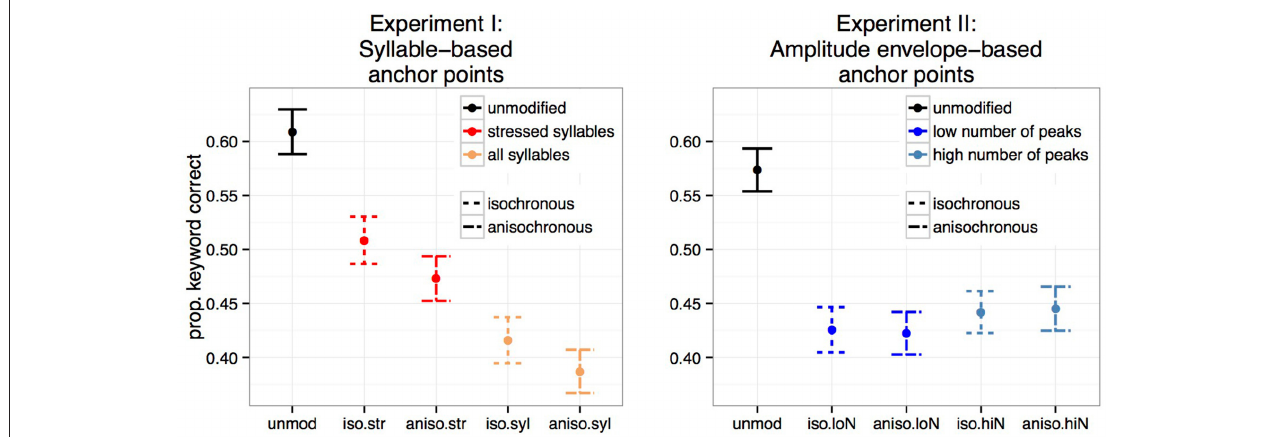
FIGURE 4 | Mean proportion of correctly identified keyword per sentence over participants for the five conditions. Experiment I: syllable-based anchor points ( N = 26). Experiment II: amplitude envelope-based anchor points ( N =